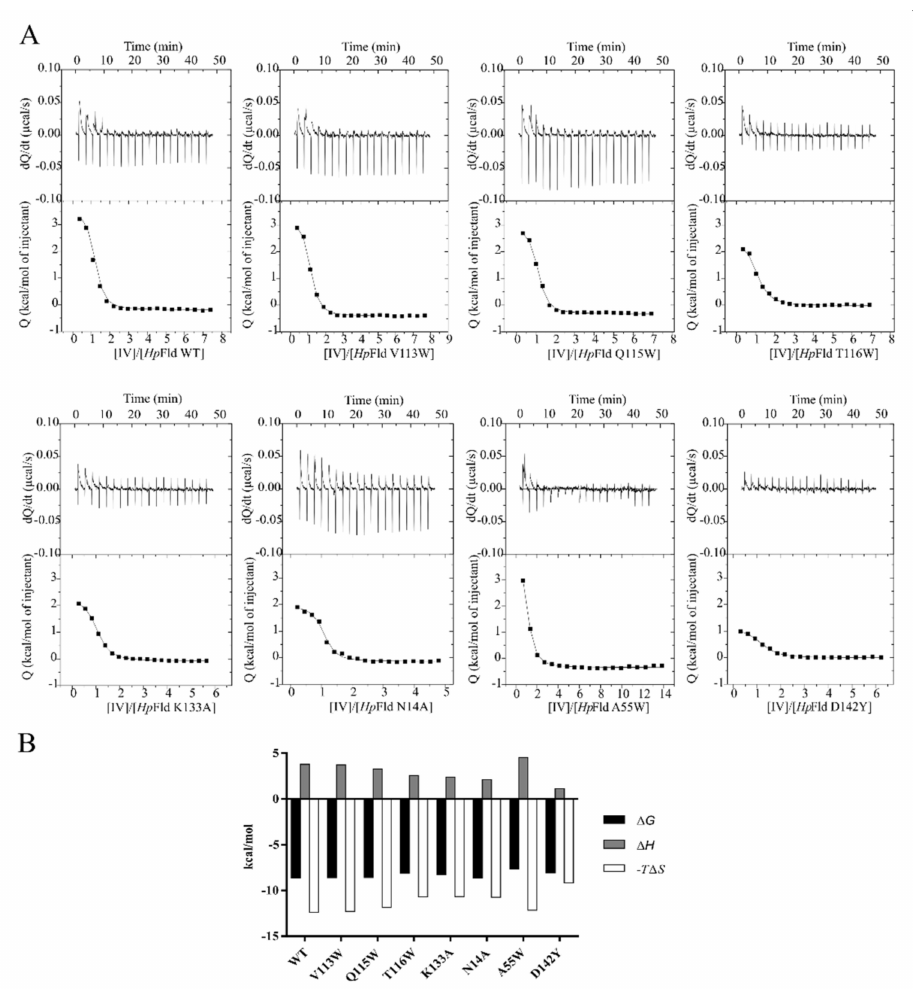
Figure 4. Thermodynamic analysis of the interaction between compound IV and wild-type Hp -Fld and mutants N14A, V113W, Q115W, T116W and K133A by ITC. ( A ) The upper plots show the thermograms (thermal power as a function of time), whereas the lower panels exhibit the binding isotherms (titrant normalised heat effects as a function of the ligand:protein molar ratio in the cell). In these last ones, the solid line corresponds to the best fit. ( B ) Thermodynamic parameters of each flavodoxin interaction with compound IV. Gibbs energy ( ∆ G ), enthalpy ( ∆ H ) and entropic contribution ( − T ∆ S ) are represented in black, grey and white bars,